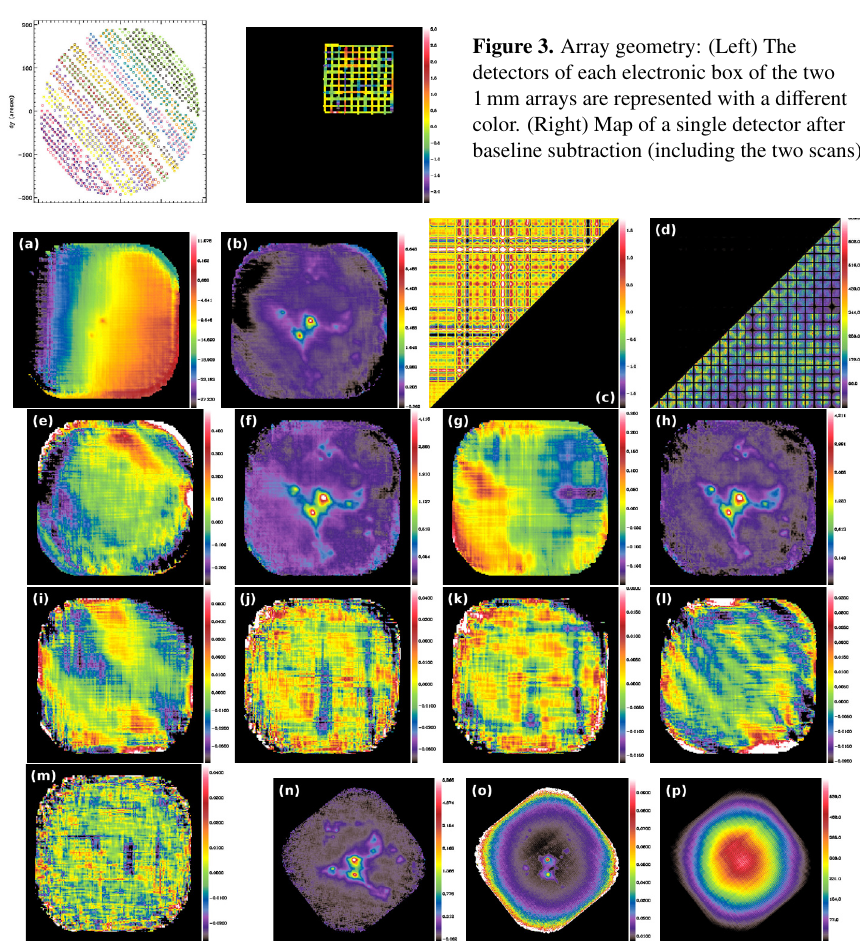
Figure 4. Intermediate and final maps: (a) Raw data ; (b) After first baseline subtraction ; (c) Matrix of the average drift di ff erences ∆ ( t 1 , t 2 ) ; (d) Weights associated with ∆ ( t 1 , t 2 ) ; (e) Projection of the subtracted average drift on small timescales ; (f) After subtraction of the average drift ; (g) Projection of the baselines computed after step f ; (h) After second baseline subtraction ; (i) Projection of the av- erage drift per electronic box, on the 3 . 11s timescale ; (j) Projection of the average drift per electronic sub-box, on the 3 . 11s timescale ; (k) Projection of the individual drifts, on the 3 . 11s timescale ; (l) Pro- jection of the average drift per electronic box, on the 1 . 04s timescale ; (m) Projection of the individual drifts, on the 1 . 04s timescale ; (n) Final map ; (o) Error map ; (p) Weight